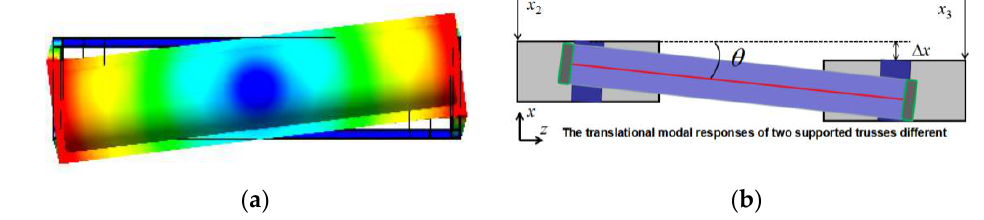
Figure 1. Misalignment principle diagram of spatial filter and its support truss coupled Optomechanical system: ( a ) Integrated support ANSYS torsion pendulum posture; ( b ) split support torsion pendulum posture.